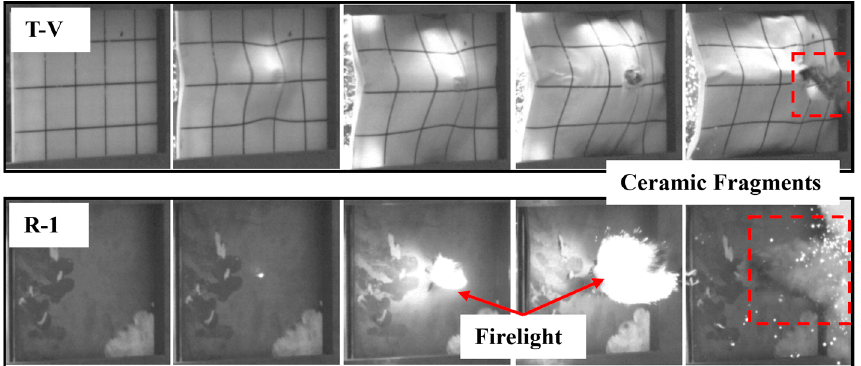
Figure 16. High-speed image sequences of T-V and R-1.